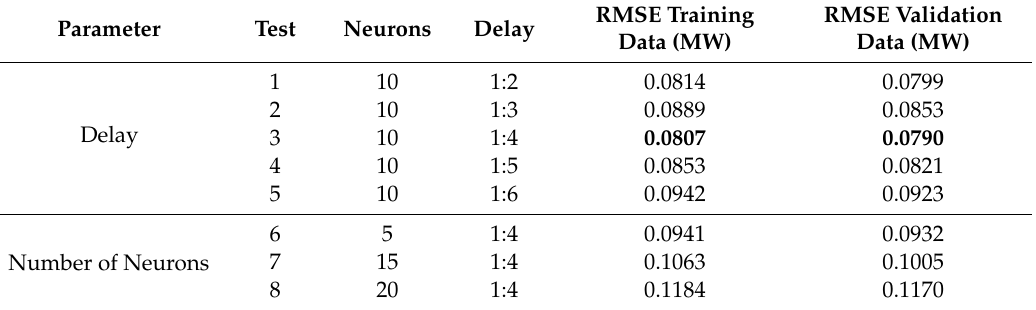
Table 4. Structure design test for option 2.